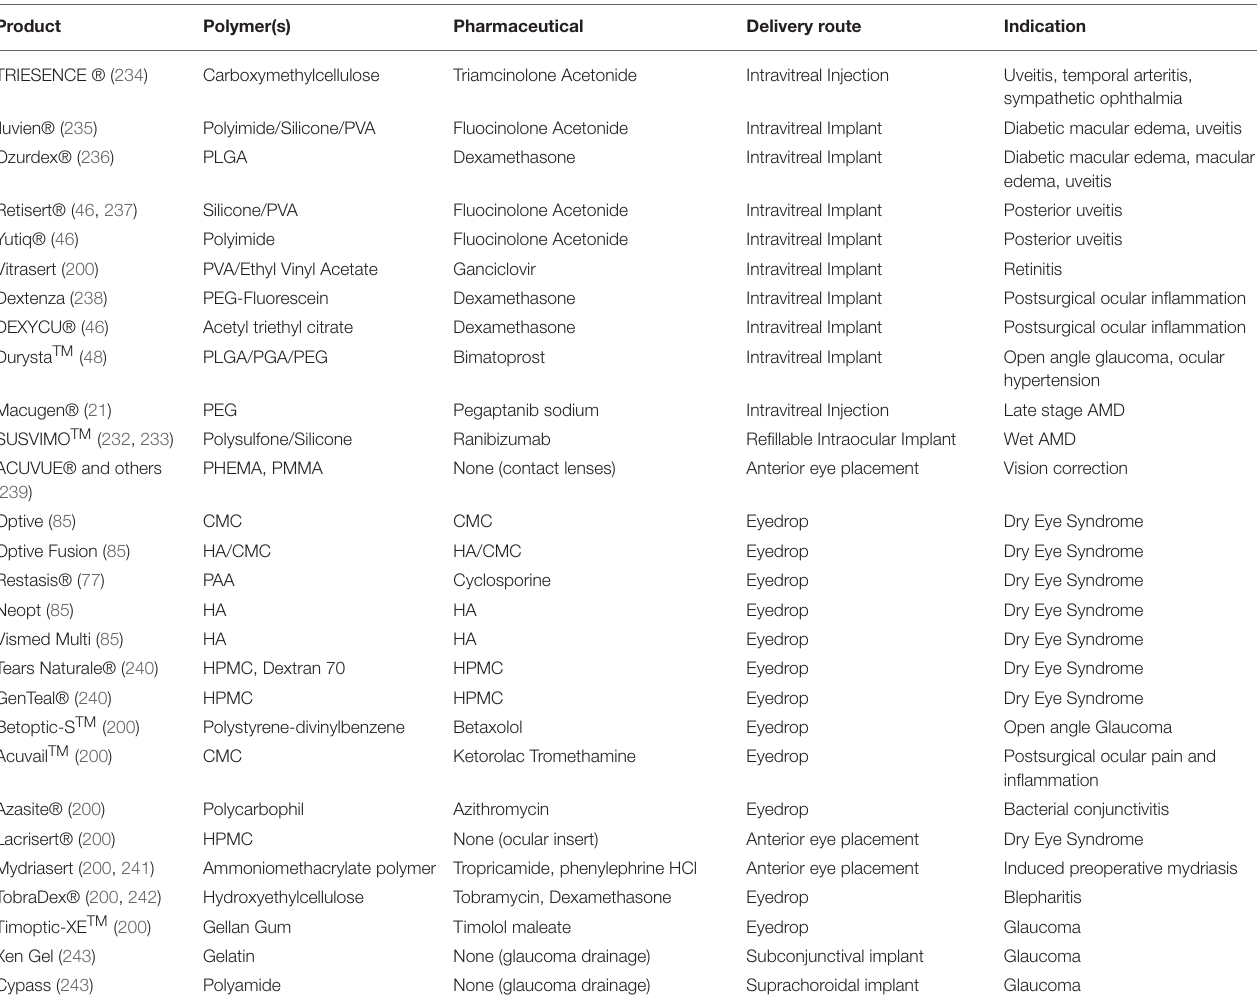
TABLE 3 | Polymer-based ocular drug delivery systems with FDA